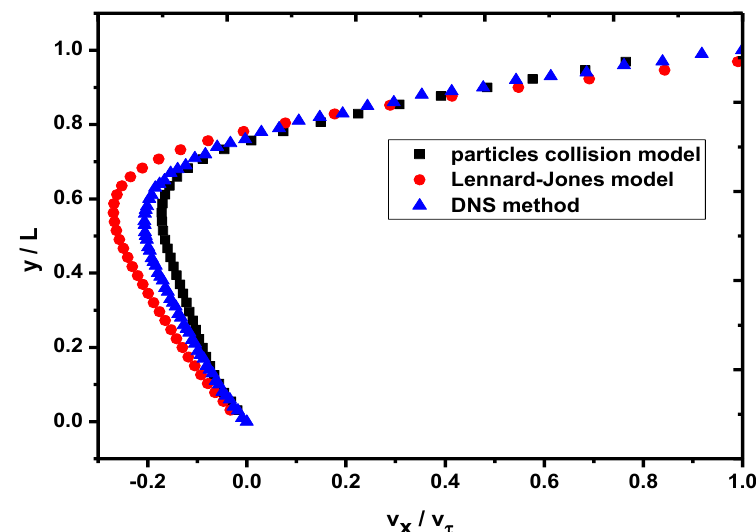
Fig. 8. The variable curves of horizontal velocities along the vertical centerline.